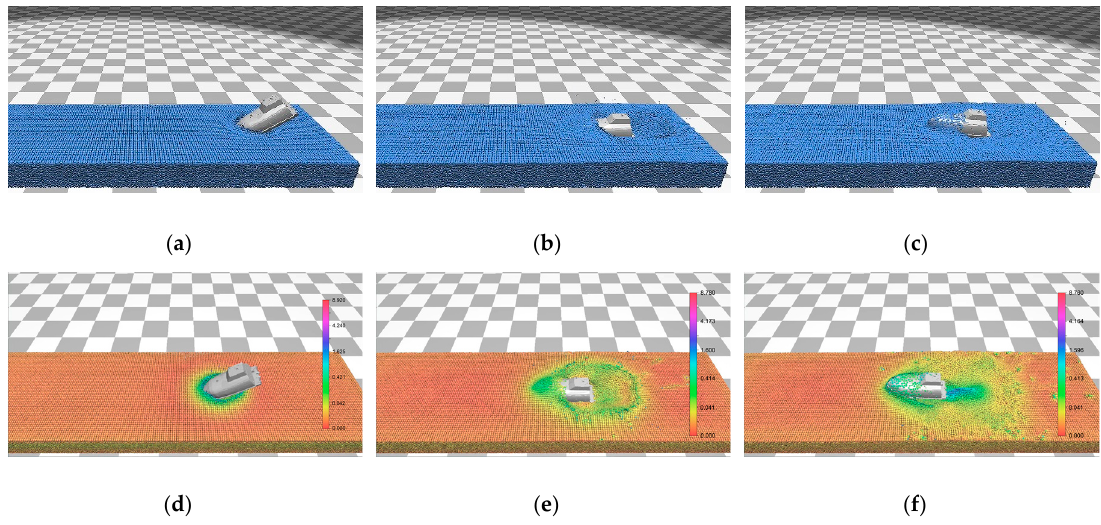
Figure 12. Scene of lifeboat entering water with 312.8 k fluid particles. The lifeboat enters the water at an angle of 45 degrees to the calm ocean surface: ( a – c ) the di ff erent stages of entry process of lifeboat, which are selected from three di ff erent time steps; and ( d – f ) the velocity distributions of fluid particles. The time instances in ( a – c ) are the same as in ( d – f ), respectively. The color bars on the right sides of ( d – f ) denote the modules length of the velocity. The unit of velocity in ( d – f ) is m/s.